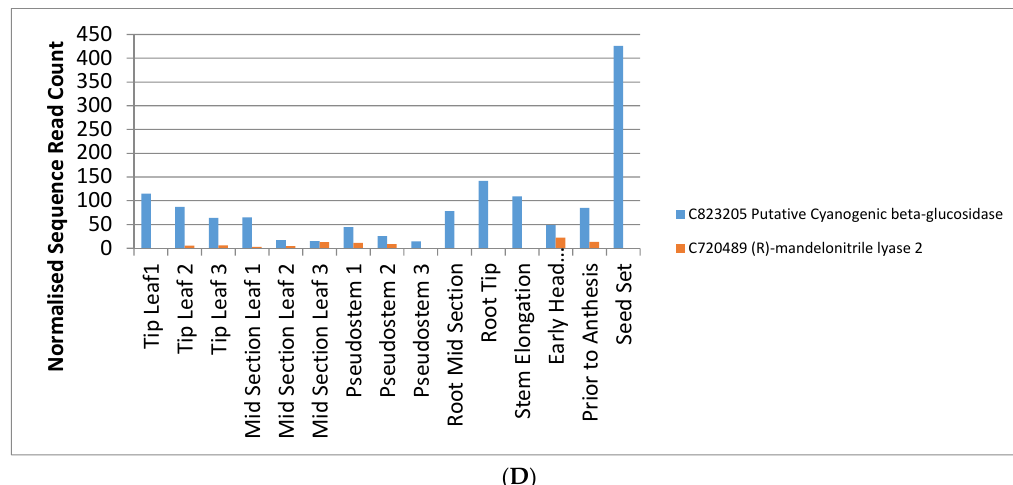
Figure 3. Expression profiles of selected candidate genes for various trait ‐ specific categories: ( A ) aluminium tolerance; ( B ) reproductive development; ( C ) lignin biosynthesis; ( D ) toxin production. The identities of sampled tissue types are shown on the y = 0 axis, while the x = 0 axis represents transcript abundance in terms of normalized sequence read count.